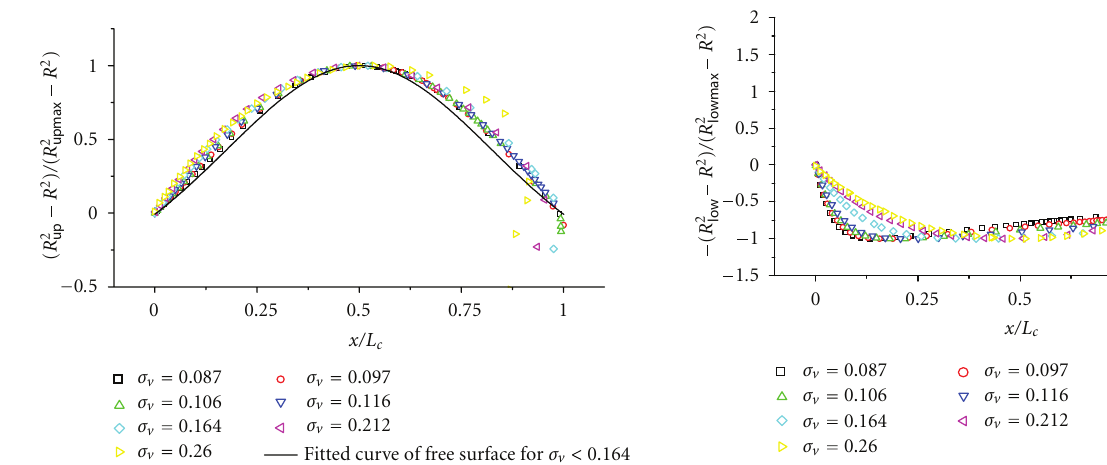
Figure 8: Universal profiles of the upper surface of the cavity at di ff erent σ v , h/H = 0 . 50.